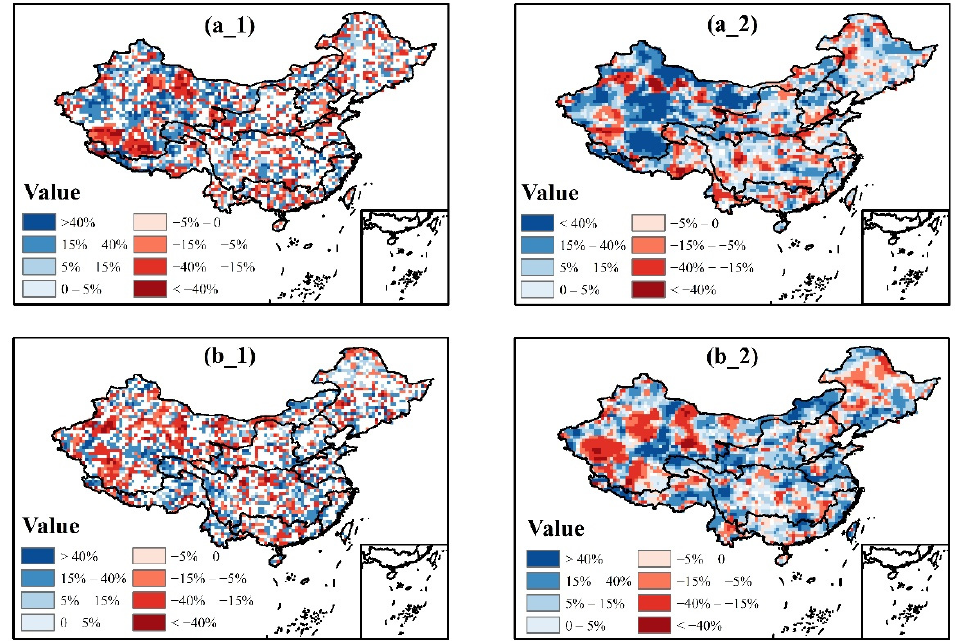
Figure 5. Percentage of differences in drought characteristics under NSPEI and SPEI. ( a_1 ) shows the duration in the spring–summer seasons; ( a_2 ) shows the severity in the spring–summer seasons; ( b_1 ) shows the duration in the fall–winter seasons; ( b_2 ) shows the severity in the fall–winter sea- sons.